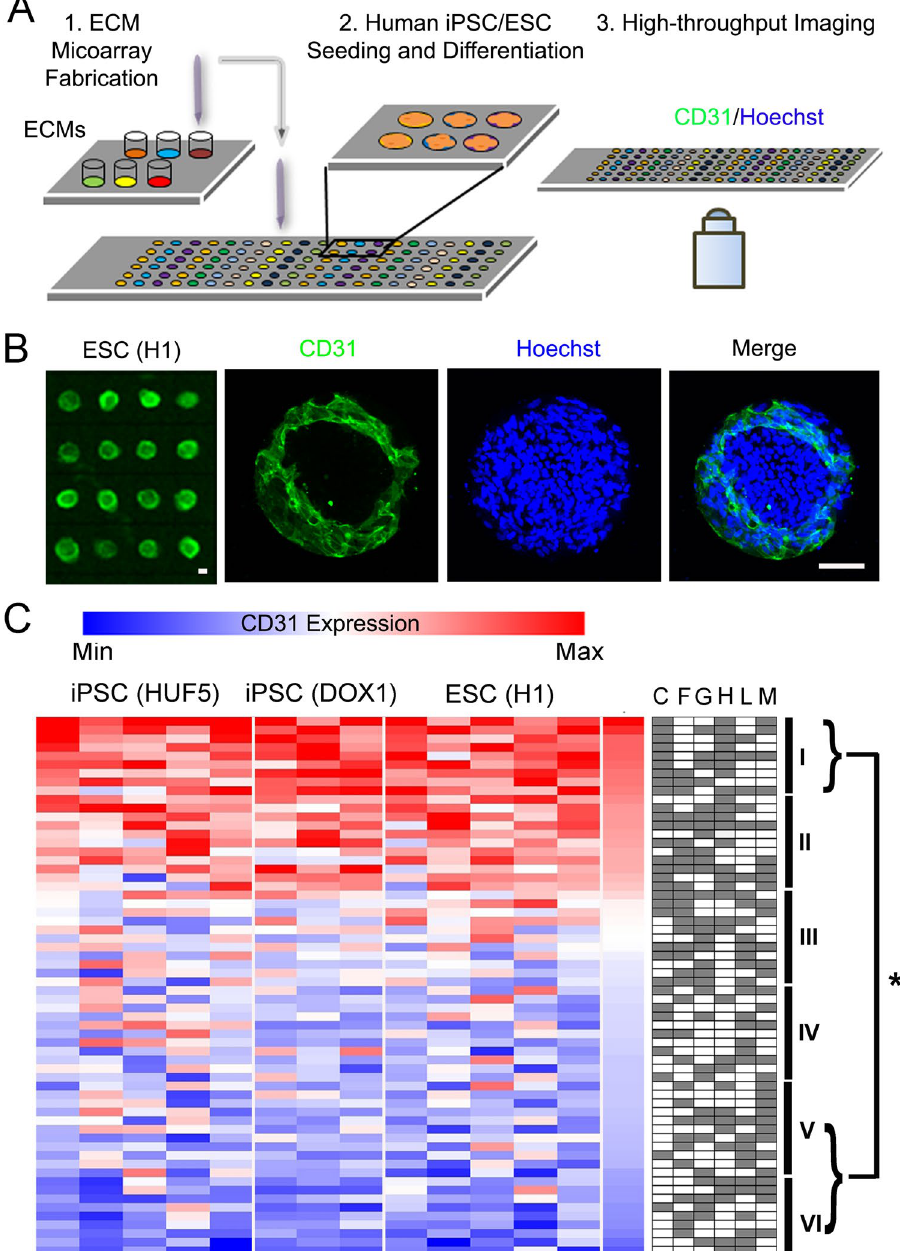
Figure 1. Multi-component ECMs promote endothelia differentiation in human iPSCs and ESCs. ( A ) Schematic diagram of ECM microarray fabrication and endothelial differentiation. First, the ECM microarray was fabricated from six ECMs and 63 distinct combinatorial ECMs. Human iPSCs or ESCs were then seeded and differentiated on the microarray. Afterwards, high-throughput imaging was performed using the ImageXpress Micro high- content imaging system. ( B ) ImageXpress (left) and confocal (right) images of representative ESCs on ECM microenvironments after 5 days of endothelial differentiation. The confocal images shown at high magnification depict endothelial differentiation on an island of matrigel. Green, CD31; Blue, Hoechst 33342. Scale bar, 100 µ m. ( C ) Heat map of normalized CD31 expression for each independent microarray slide generated from three cell lines: iPSCs (HUF5, n = 5), iPSCs (DOX1, n = 3) and ESCs (H1, n = 5). Integrated fluorescence data was measured and normalized to cell numbers from each ECM microenvironment. The normalized average data was log 2 -transformed and globally normalized to the mean of all 63 ECM combinations to generate the Z scores, which were ranked in the heat map of CD31 expression from low (blue) to high (red) levels. Each column represents an independent ECM microarray slide, whose data was averaged among the 6 replicates per slide. The identity of all 63 combinatorial ECMs is shown on the right in which white or grey boxes denotes the absence or present, respectively, of an ECM component. Combinatorial ECMs were grouped into six tiers from high (Tier I) to low (Tier VI). Tier I combinatorial ECMs significantly promoted CD31 expression when compared to any ECMs in Tier V and VI. * Denotes P <